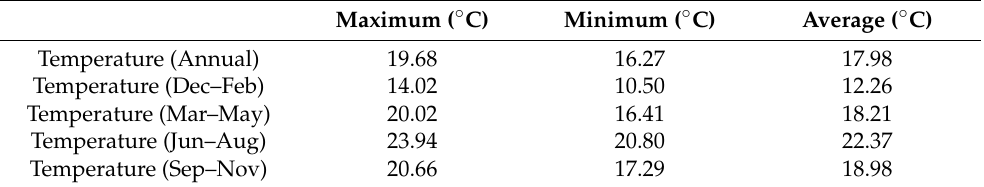
Table 2. Maximum, minimum and average temperature [19] where Paphiopedilum fairrieanum was found growing in the study